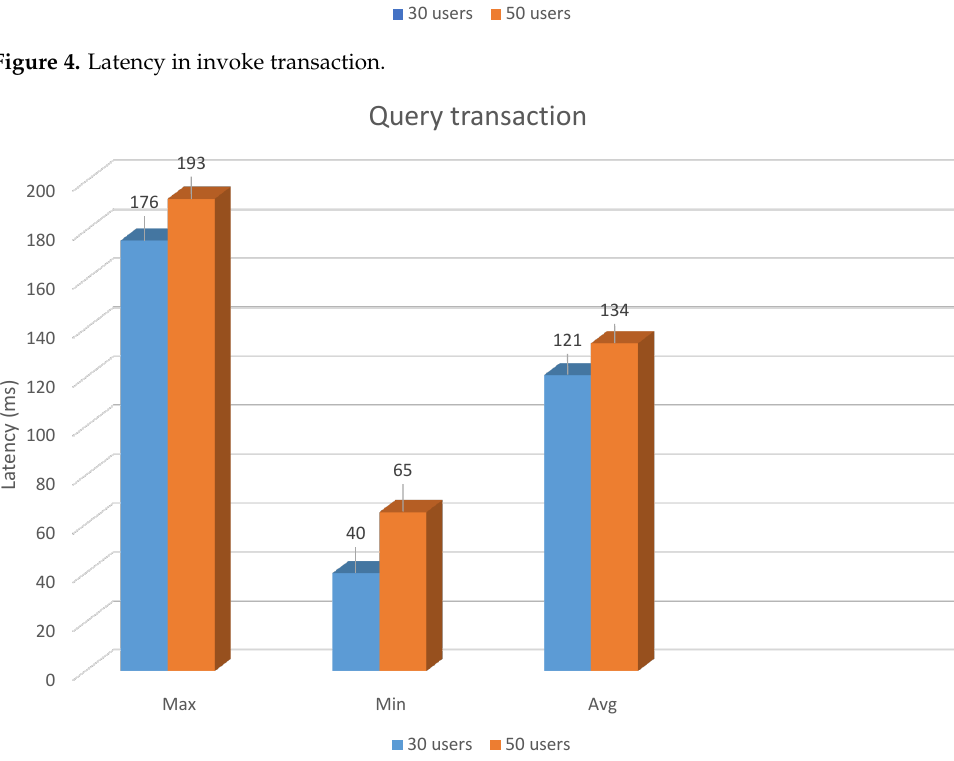
Figure 5. Latency in query